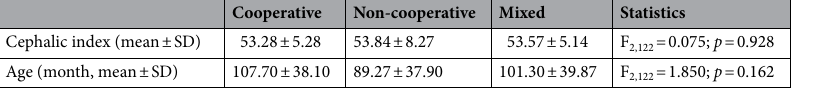
Table 1. Cephalic index and age distribution of the sample among the different breed function